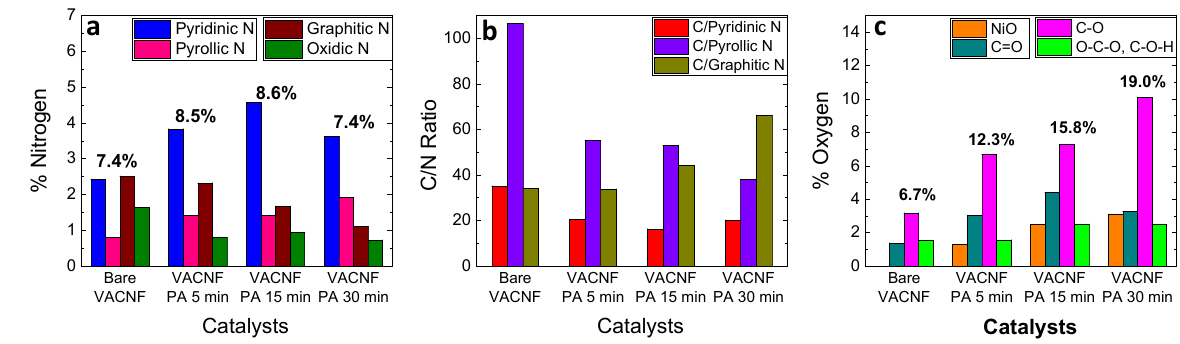
Figure 3. ( a ) Atomic% of different types of nitrogen, ( b ) ratio of C to N, and ( c ) atomic% of different types of oxygen in bare VACNF and VACNF samples plasma annealed for different time intervals.